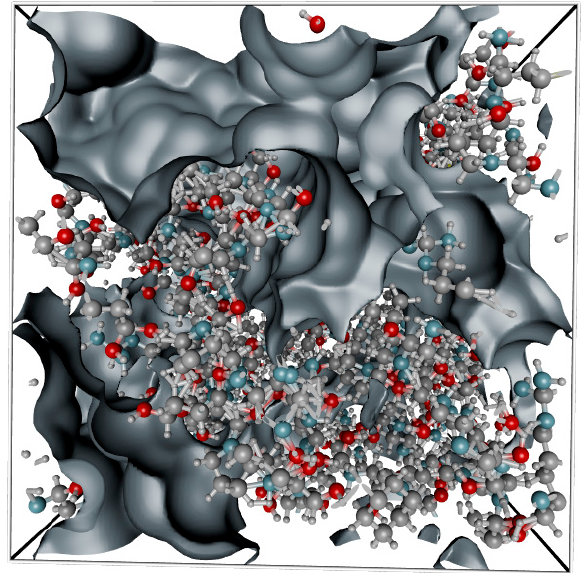
Figure 10. The grey surface indicate free volume surface created by the water molecule probe. The carbon atoms are colored in grey, oxygen in red, nitrogen in blue and hydrogen in white.